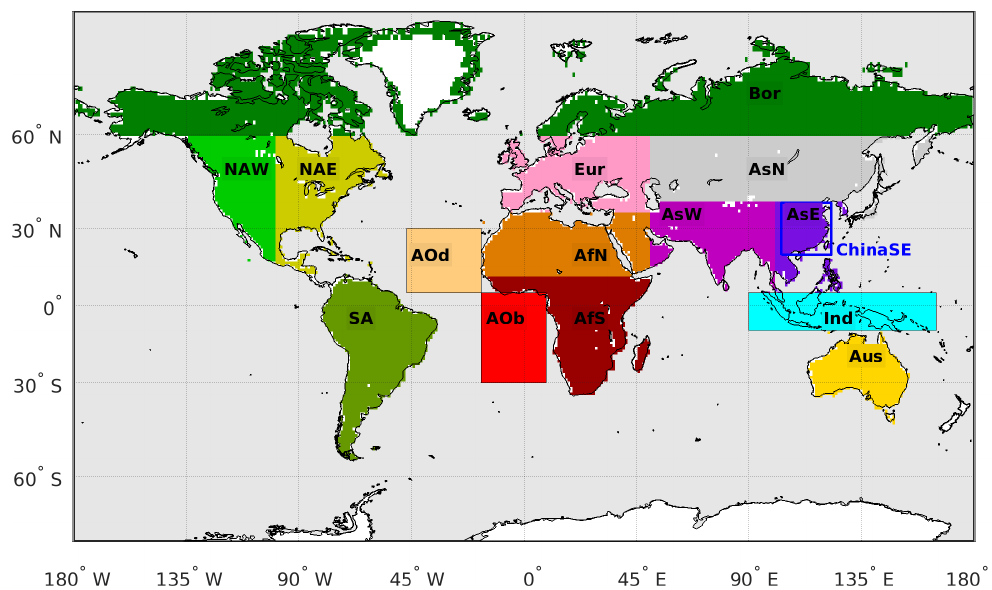
Figure 1. Fifteen land and ocean regions defined in this study: Europe (Eur), Boreal (Bor), northern Asia (AsN), eastern Asia (AsE), western Asia (AsW), Australia (Aus), northern Africa (AfN), southern Africa (AfS), South America (SA), eastern North America (NAE), western North America (NAW), Indonesia (Ind), Atlantic Ocean dust outflow (AOd) and Atlantic Ocean biomass burning outflow (AOb). In addition, south-eastern China (ChinaSE), which is part of the AsE region, marked with a blue frame, is considered separately. Land, ocean and global AOD were also